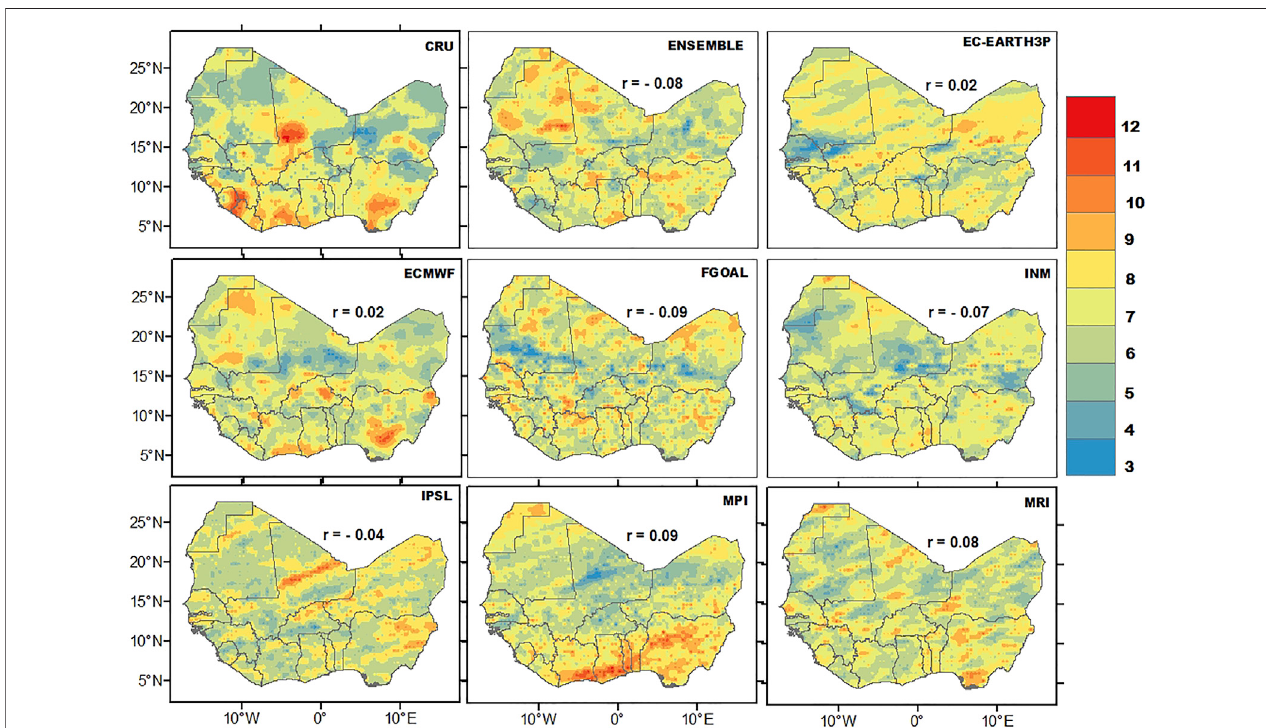
FIGURE 13 | Same as Figure 11 but for the frequency of hydrological drought (SPEI-12).